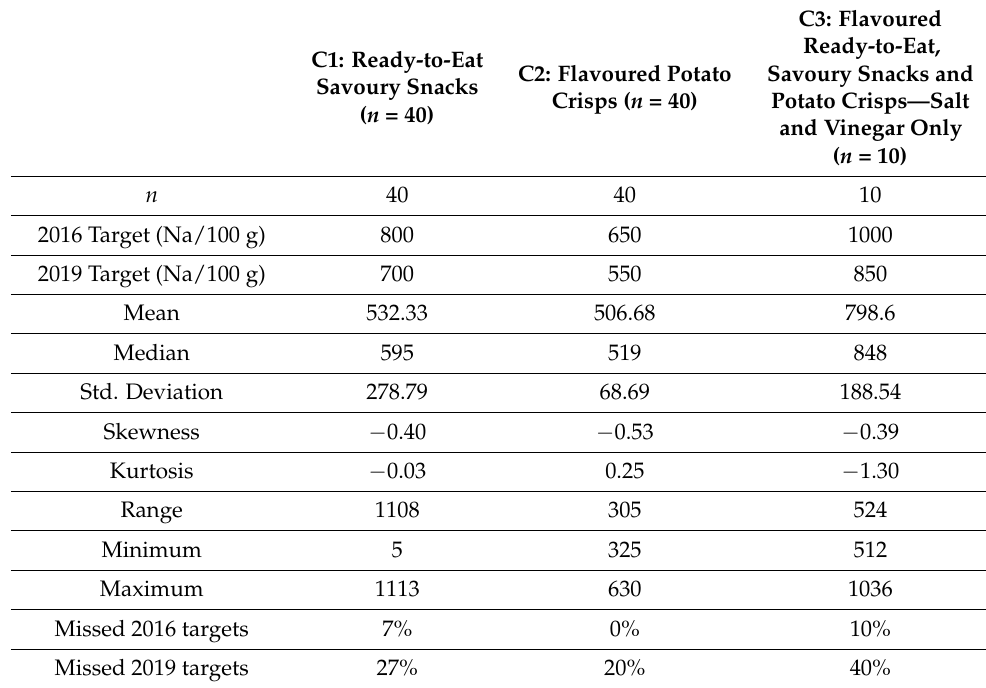
Table 2. Product performance against Na/100 mg benchmarks or targets for 2016 and